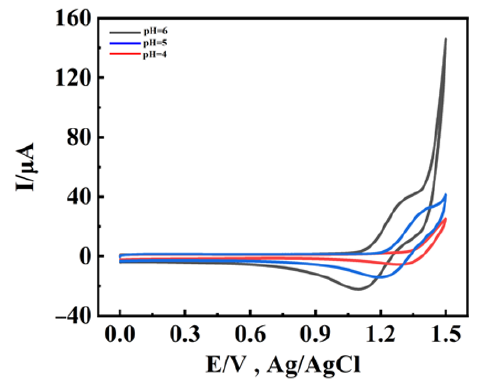
Figure 2. CVs of 0.1 mM Ni25 in 1 M NaAc + HAc with different pH values (4, red curve; 5, blue curve; and 6, black curve) at the scan rate of 50 mV s −1 using the ITO electrode.